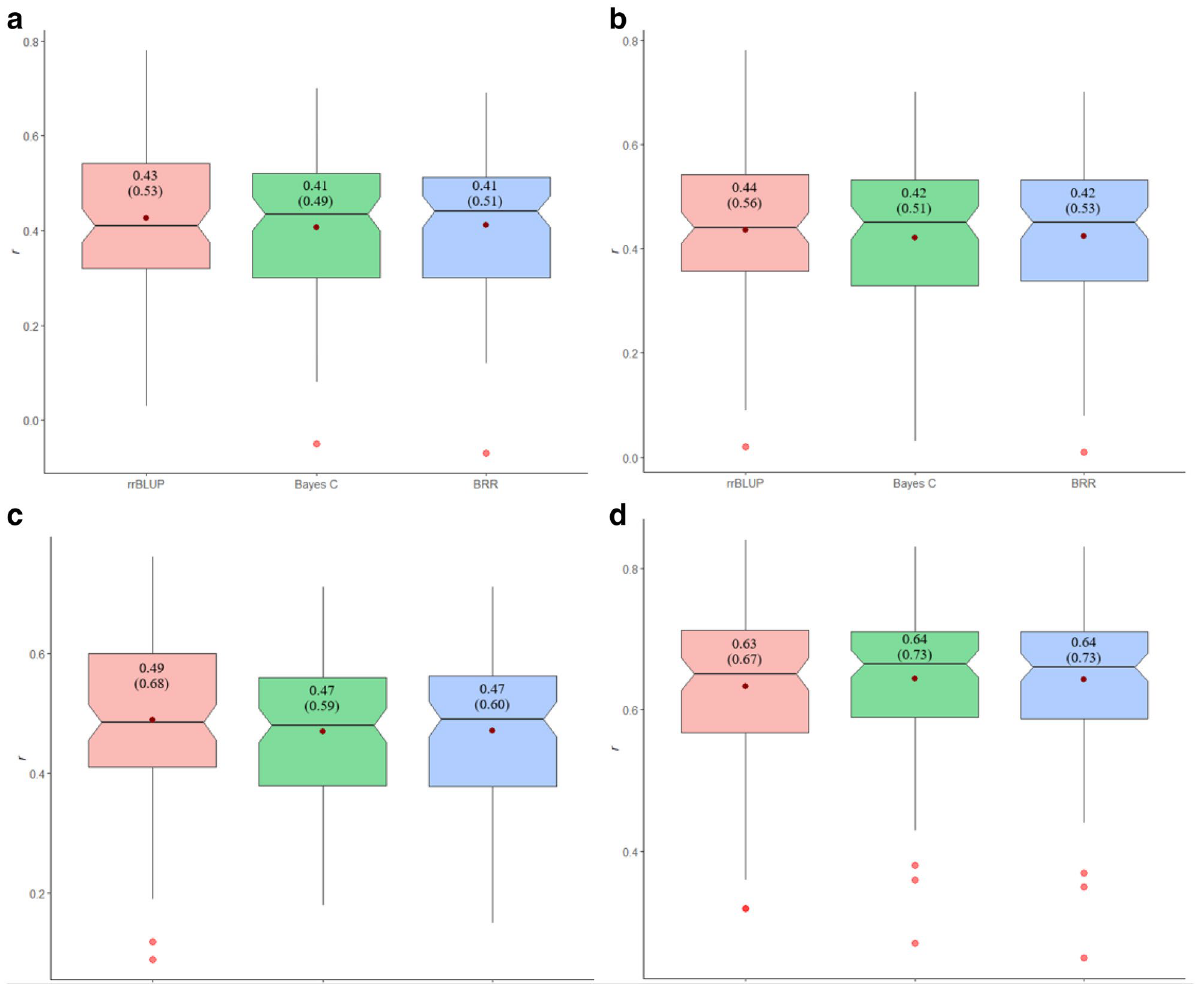
Figure 6. Predictive ability and accuracy for sclerotinia stem rot resistance associated phenotypic traits estimated from the fivefold cross-validation schemes of the association panel. ( a ) Boxplot showing the result of average predictive ability ( r ) (y axis) and accuracy for combENV stem lesion length, ( b ) combENV stem lesion width, ( c ) combENV plant mortality at 14 days post inoculation (PM_14D), ( d ) combENV plant mortality at 21 days post inoculation (PM_21D) with rrBLUP, Bayes C and Bayesisan ridge regression (BRR) models (x-axis). The boxes show second and third quartiles and wishkers show interquertile range. The red dot in each box plot represent the mean predictive ability. The number above horizontal black bars are the predictive ability ( r ) (at the top) and accuracy (below in